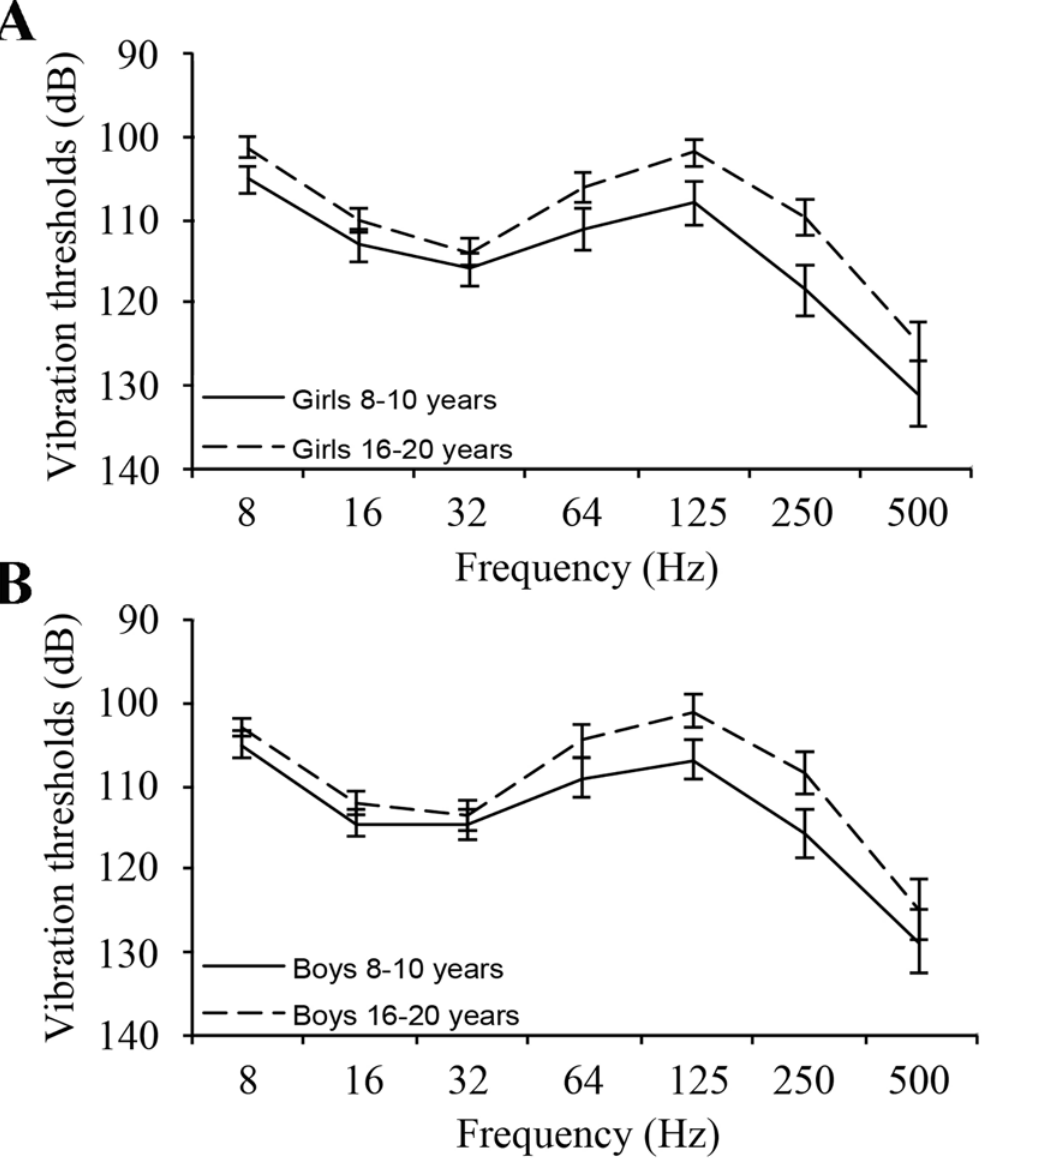
Fig 3. Spaghetti plots with vibration perception thresholds. Vibration perception thresholds at different frequencies from the index fingers in young (8 – 10 years) and older (16 – 20 years) children in girls (A) and boys (B). Values, expressed in dB (relative to 10 -6 m/s 2 ), are means and 95% confidence